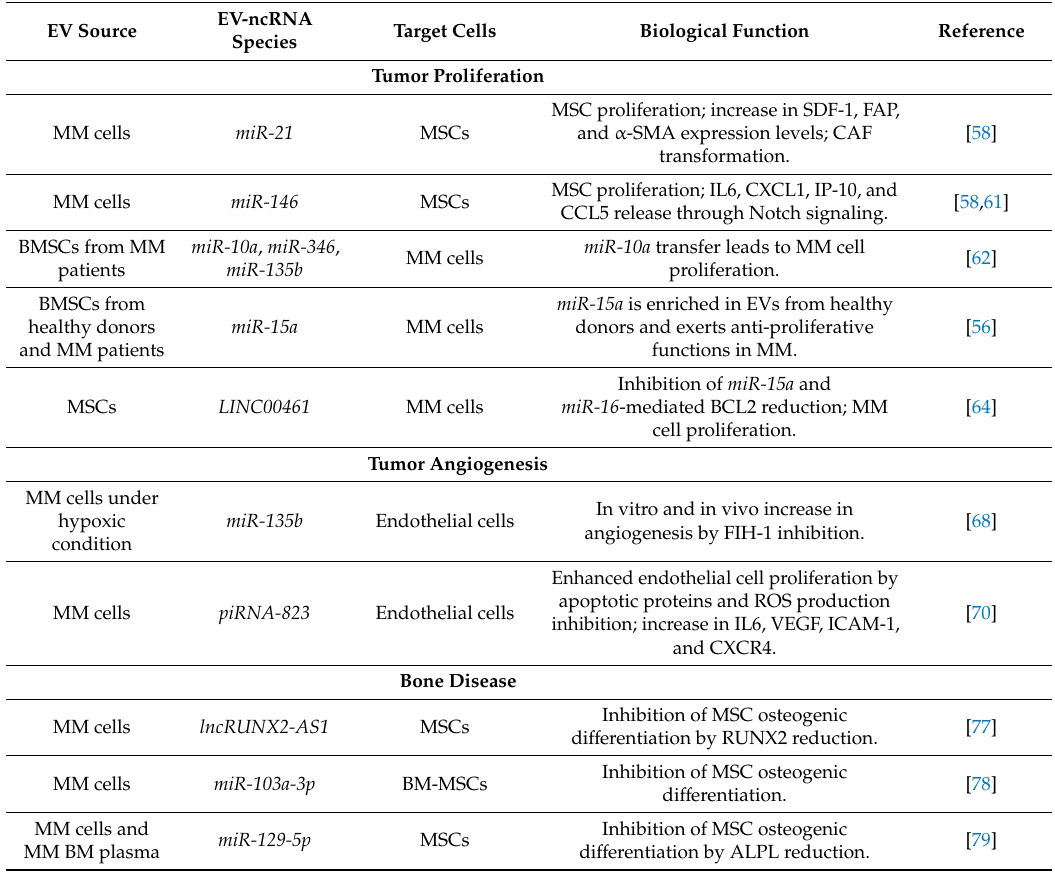
Table 1. E ff ects of EV-ncRNAs on MM pathobiology.